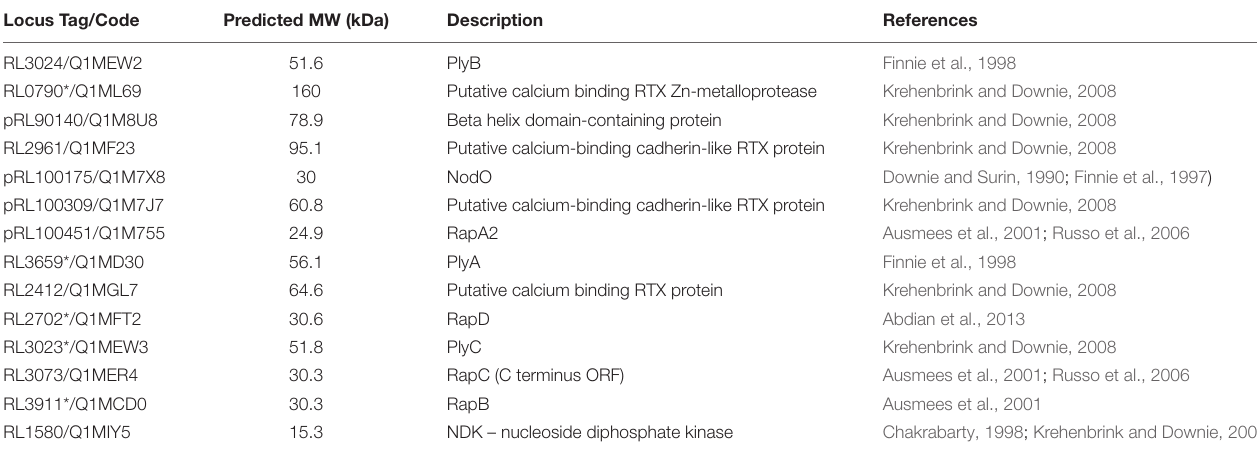
TABLE 1 | PrsDE-dependent extracellular proteins of R. leguminosarum bv. viciae 3841. Locus Tag/Code Predicted MW (kDa) Description